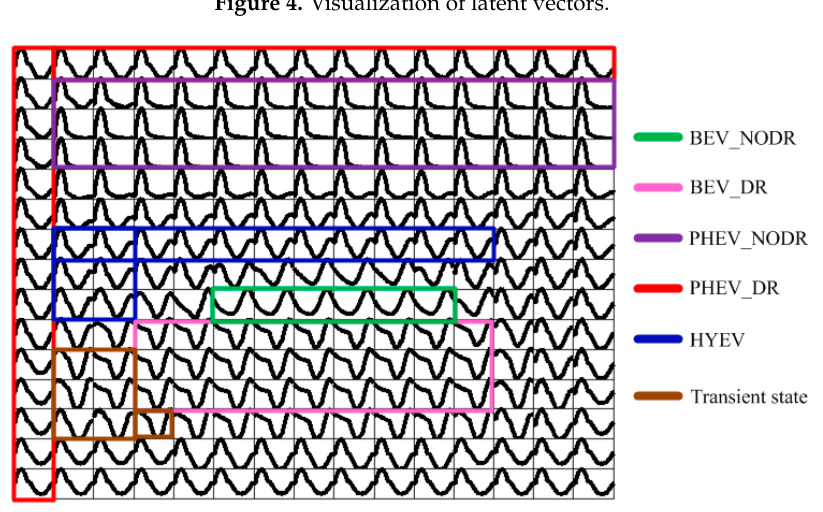
Figure 5. Visualization of 15 × 15 load profiles based on latent vectors.